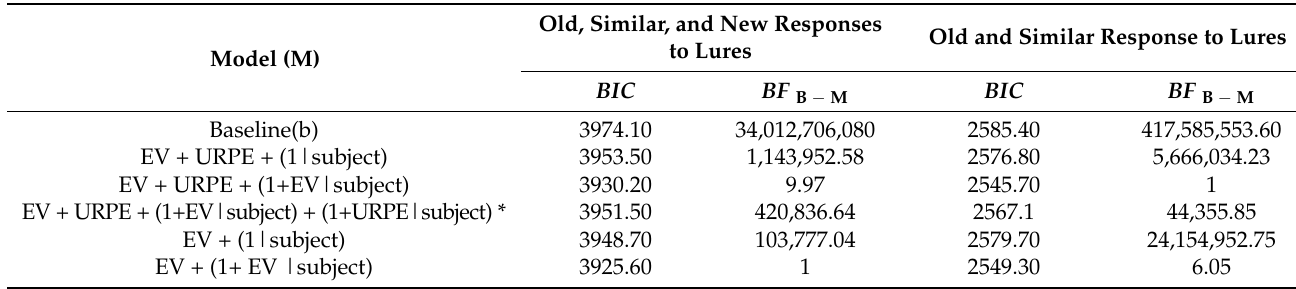
Table 4. Generalized linear mixed-effects model comparison in Experiment